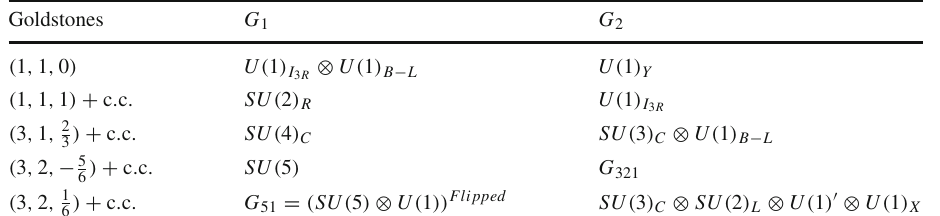
Table 2 CGCs for the SM singlets (1, 1, 0) under G 422 SSB. These SM singlets also correspond to Goldstones (1, 1,